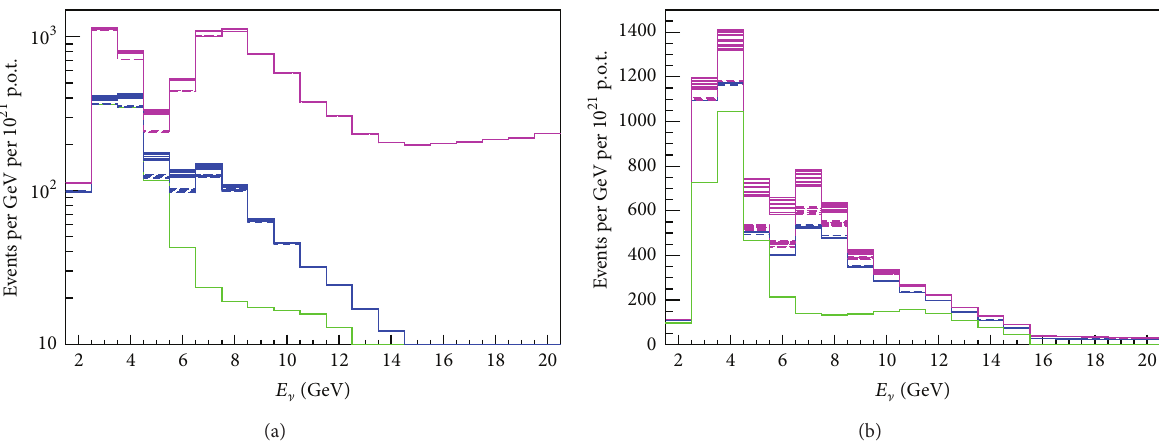
= 1.5 ⋅ 10 21 as function of the neutrino energy. (a) Track-like events. (b) Cascade-Like events. In green Figure 15: Observed events for 𝑁 pot the background from NC events is given. The blue histogram shows the total background including misreconstructed CC events. Magenta histograms are for the total event rate (signal plus background) for NH (solid) and IH (dashed) and various values of 𝜙 = 1.5 ⋅ 10 21 in the track and cascade channel for both mass hierarchy schemes and varying 𝜙 Table 1: Event numbers for 𝑁 pot Channel Tracks NH Tracks IH Cascades NH Cascades IH No oscil 26315 —